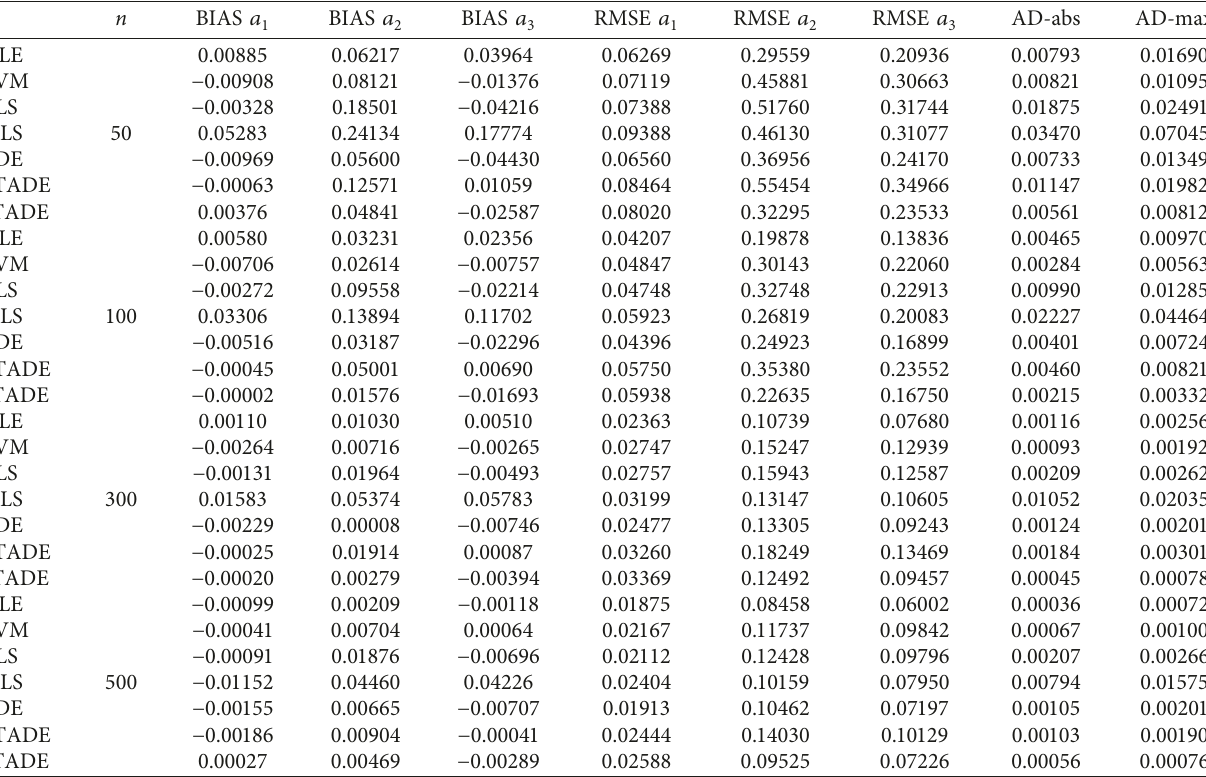
� 0.5, a � 1.5, and a 1 2